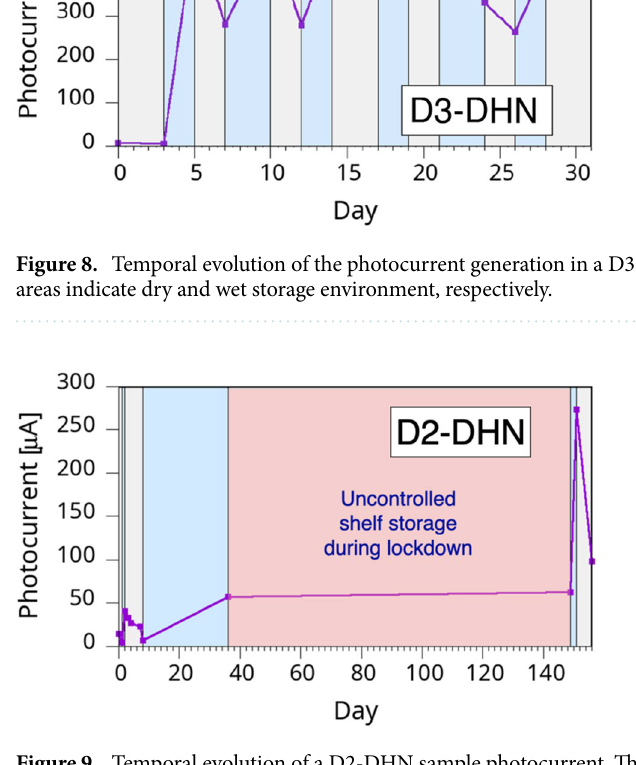
Figure 9. Temporal evolution of a D2-DHN sample photocurrent. The grey and light blue areas indicate dry and wet storage environment, respectively. The light red area indicates the temporal interval corresponding to the Covid-19 lockdown restrictions to laboratory access.